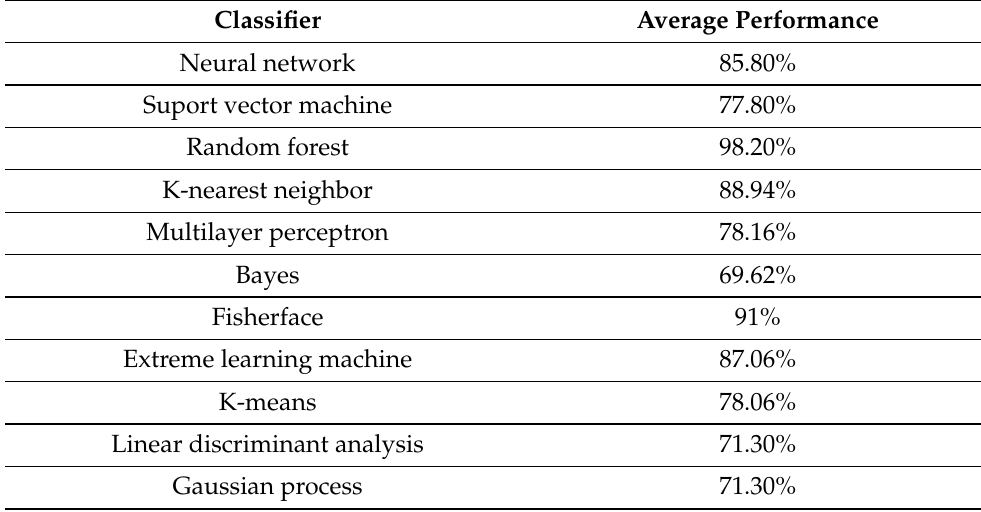
Table 2. State-of-the-art performance comparisons between analysis techniques reported in [3]. The averages of each of the techniques as compiled are shown and it is calculated that the percentage of the total performance in the 2016–2020 period is